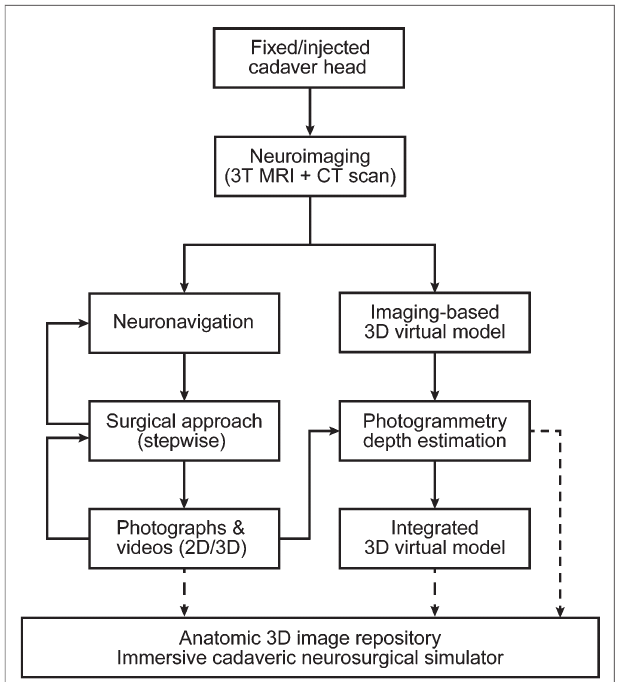
FIGURE 1 | The methodological pipeline to fully digitalize the cadavers. Used with permission from Barrow Neurological Institute, Phoenix, Arizona